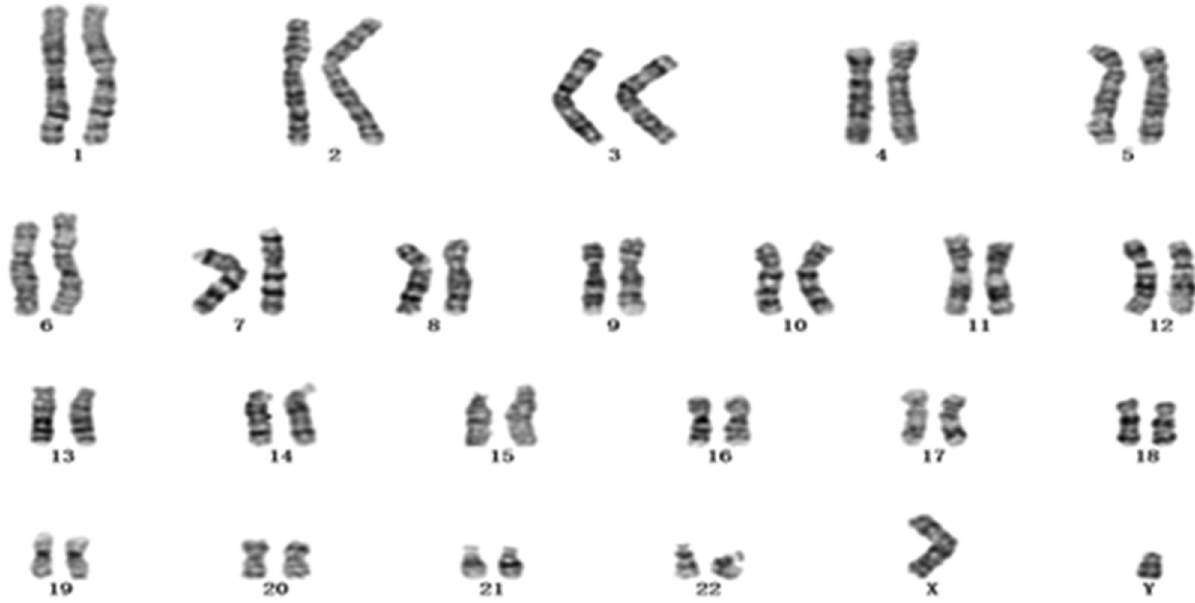
Figure 1: Normal karyotype ( 46, XY ) of the fetus identi fi ed by GTG banding